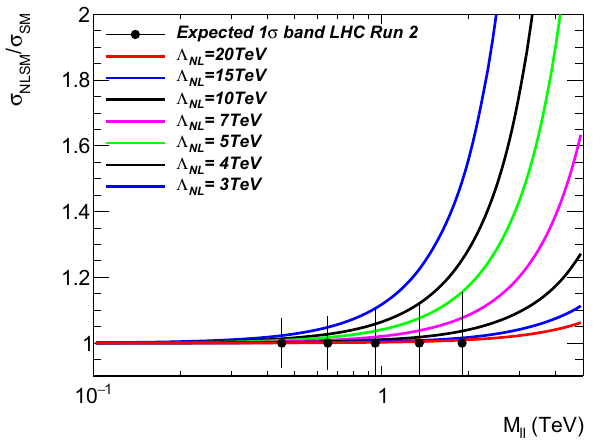
Fig. 1 Drell–Yan dilepton cross-section modification with respect to the SM prediction due to non-local effects for an integrated luminos- ity of 137 fb − 1 . The expected statistical and systematic uncertainties from a measurement at the LHC are also shown [20]. Based on these expectations, present and future measurements at the LHC can place constraints in the non-locality scale Λ NL